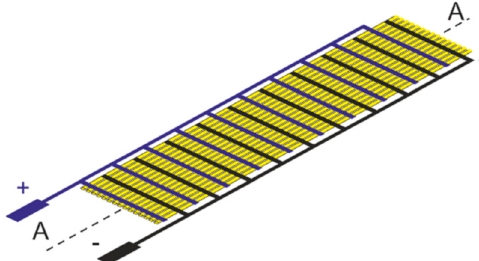
Figure 1. The scheme of a piezoelectric fiber patch (reprinted from Ref. [10] with permission from Elsevier). The finger-like electrodes are used for both the poling of the fibers and the generation of the electric fields in active operation.